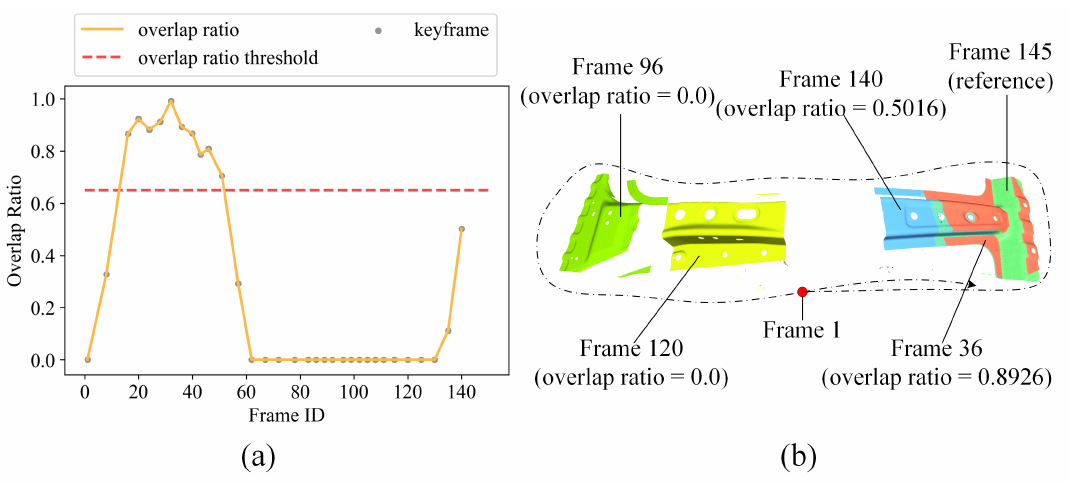
Figure 6. ( a ) The computed overlapping ratios between frame 145 with all its previous keyframes and ( b ) Frame 36, 96, 120, 140 and the reference frame